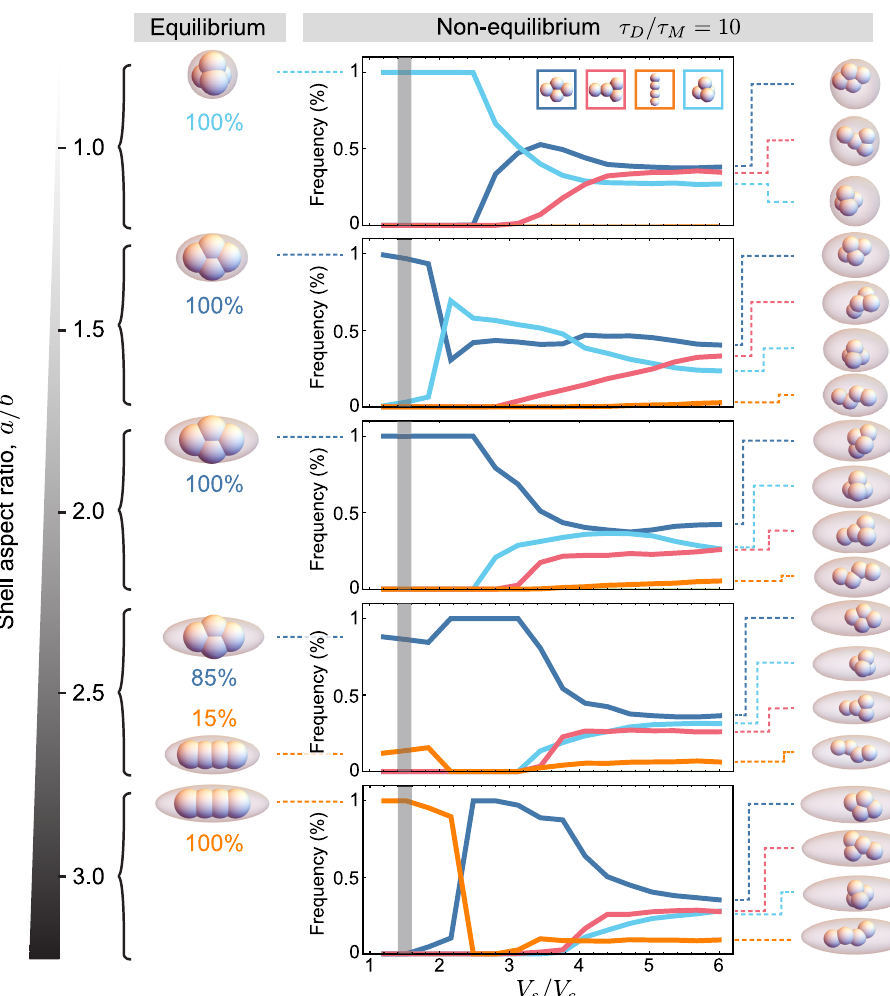
Fig 4. Cell arrangements for repulsive ellipsoidal confinement. Frequency of different cell arrangements for embryos with ellipsoidal repulsive confinement of varying aspect ratio ( a / b ) as the ratio of the shell volume and total cells volume varies (random divisions; τ / τ = 10; n = 10 4 simulation runs for each parameter set). Snapshots of non- D M equilibrium packing configurations for large shell volumes ( V s / V c = 6) are shown on the right. Equilibrium ( t = 8000 τ ) packing configurations for each aspect ratio and V / V = 1.52 are shown on the left (n = 200 simulation M s c runs for each parameter